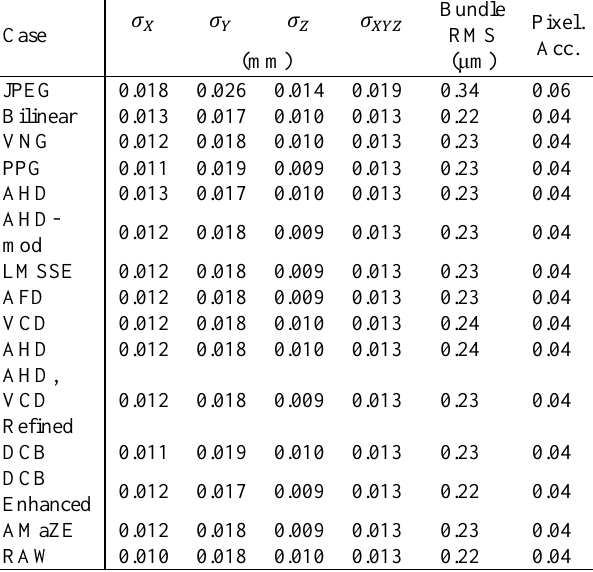
Table 1. Estimates of the mean positional standard errors for the Green channel, for different demosaicing